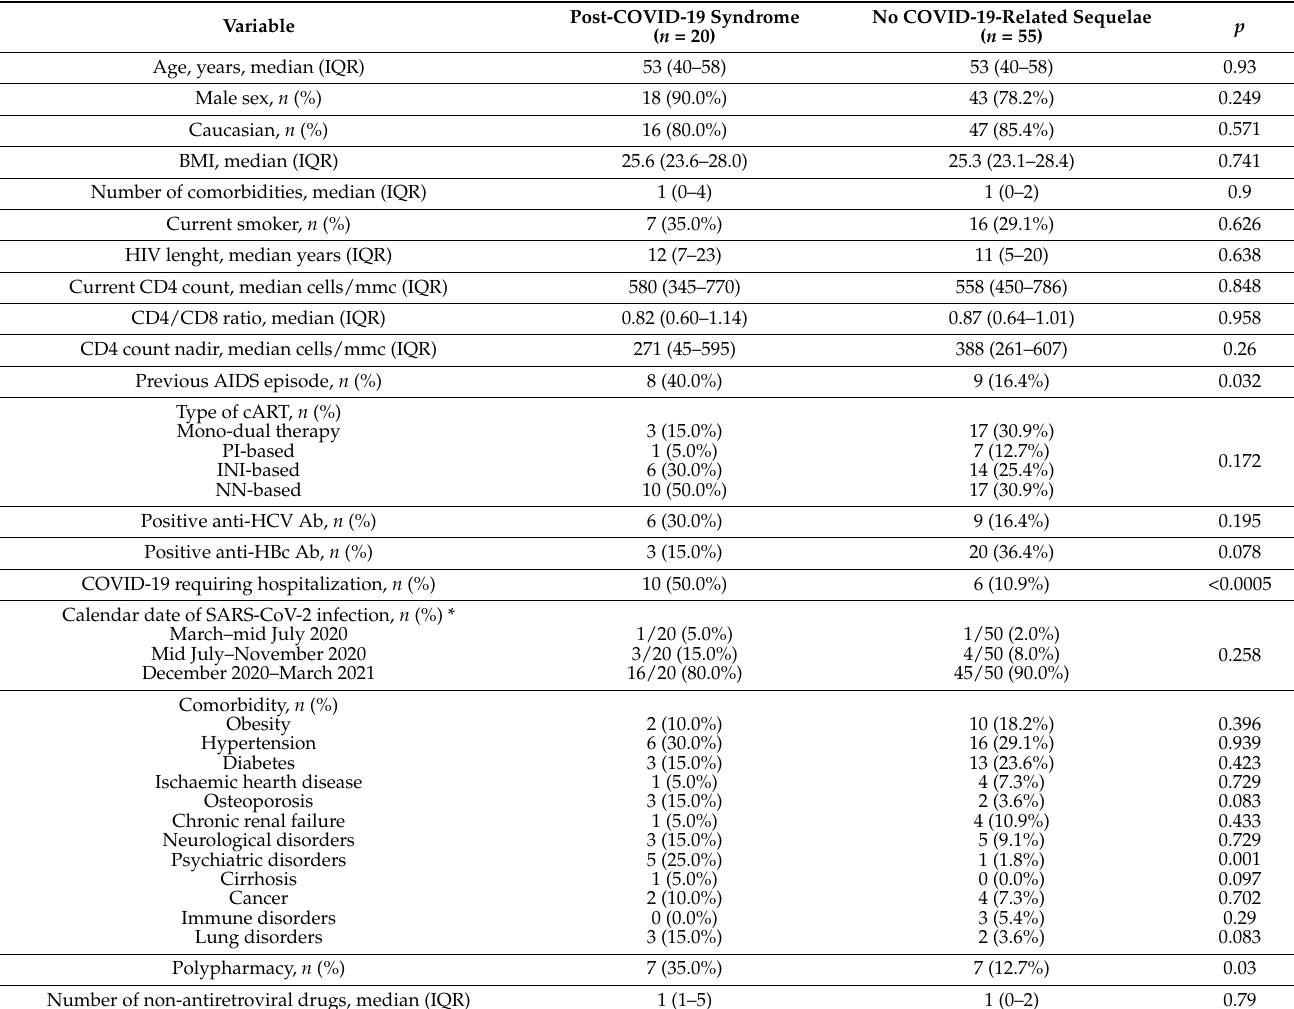
Table 2. Comparison of baseline demographic, clinical, and HIV-related parameters between PLWH with and without post-acute COVID-19